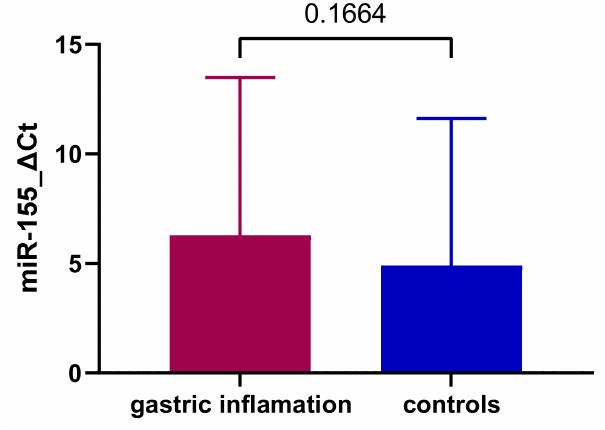
Figure 1. MiR-155 expression comparison between patients with gastritis and control group.